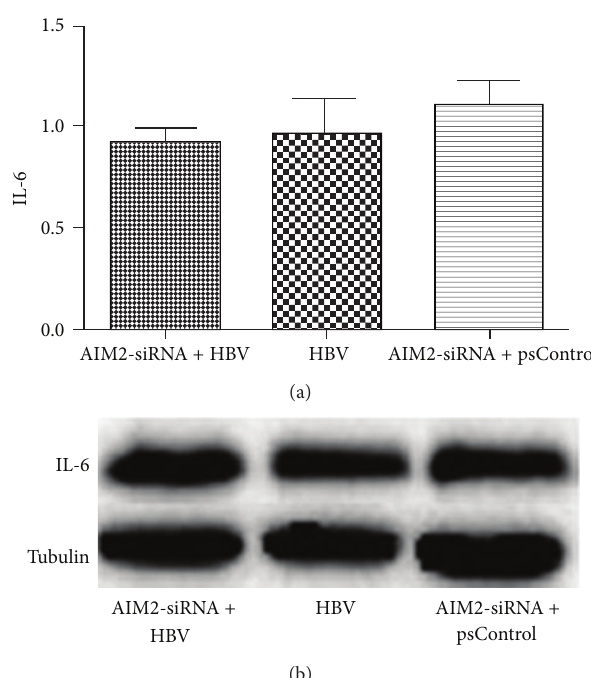
Figure 6: Downregulation of AIM2 had no influence on the expression of IL-6. HGM cells were divided into three groups: AIM2-siRNA and HBV DNA cotransfected group (group A), HBV DNA-transfectedgroupwithoutAIM2-siRNA(groupB)andAIM2- siRNA, and empty plasmids cotransfected group (group C). The expressionofIL-6ingroupAdetectedbyqRT-PCRhadnotchanged compared with group B and group C (a). These similar changes were also noted at the translational level, as measured by Western blot (b). 𝑛 = 3 independent experiment RNA samples for each